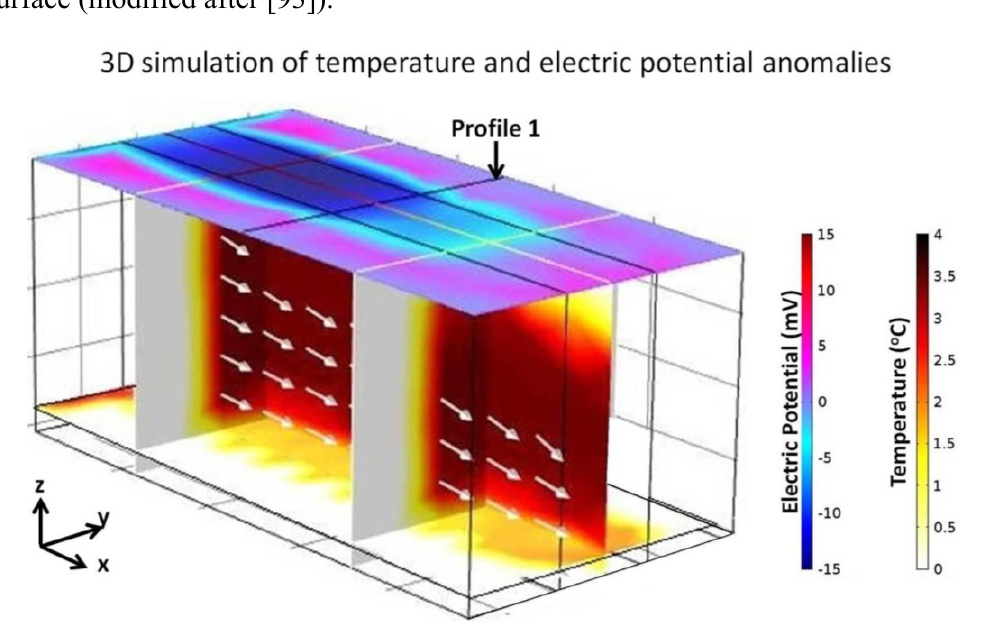
Figure 5. Time-lapse simulation of electric potential in a tank, relative to the background, following the hot injection. 3D illustration of growth of the negative self-potential anomaly in the channel at the surface, due to the temperature distribution in the channel in the subsurface (modified after